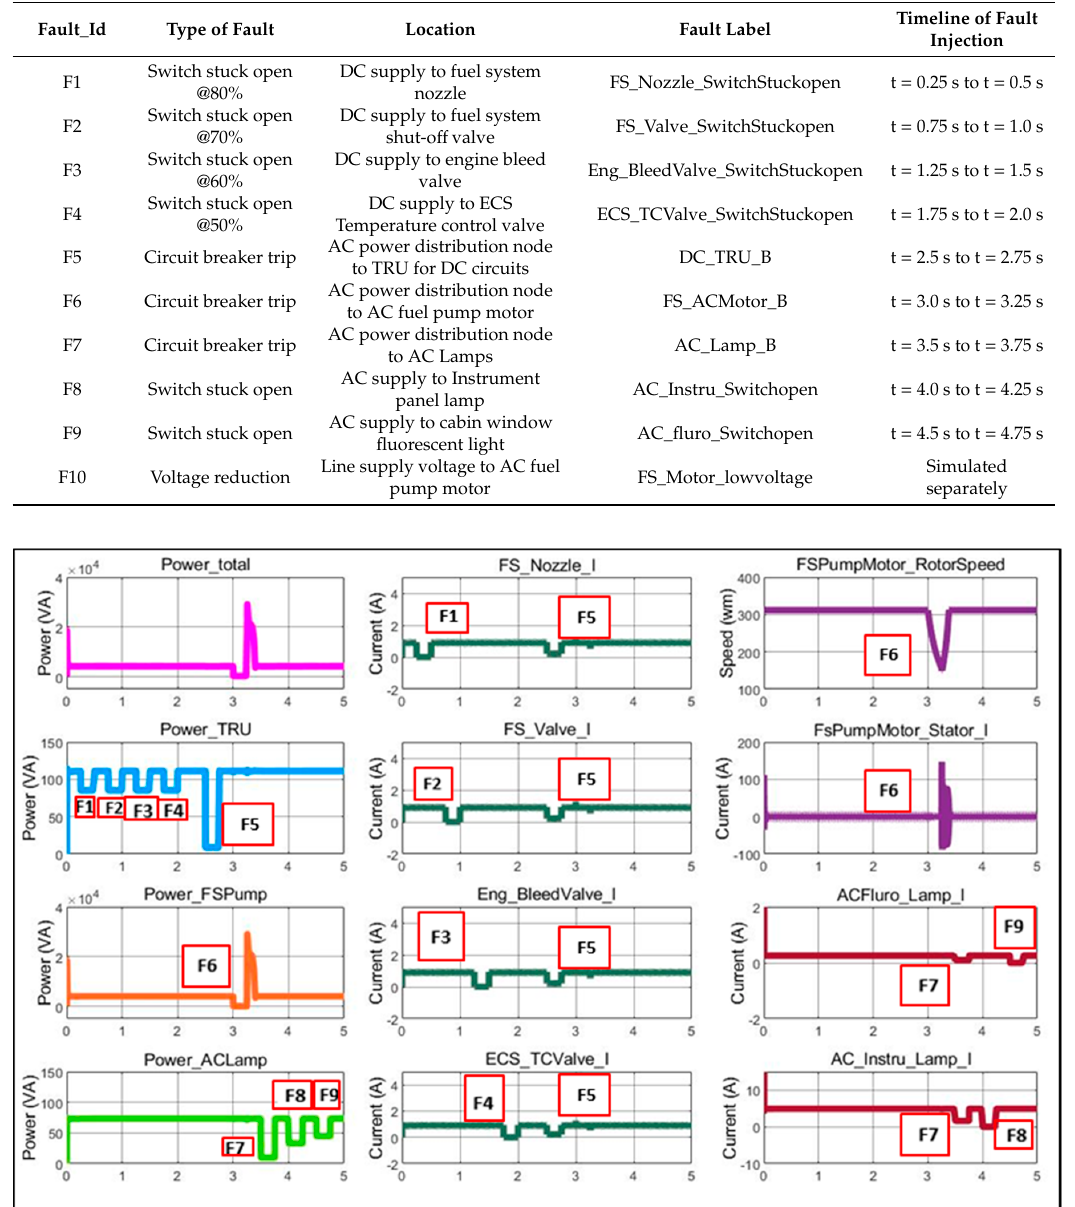
Table 2. Faults injected in the EPS Digital Twin.